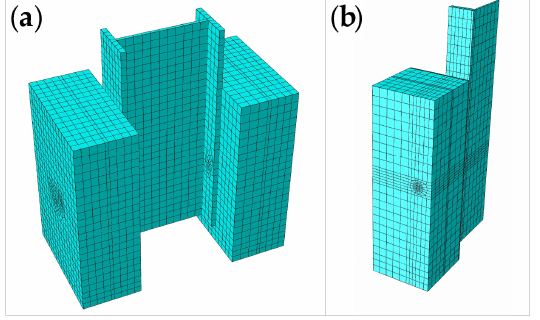
Figure 15. Finite element model of the push-out specimen: ( a ) entire model; ( b ) 1/4